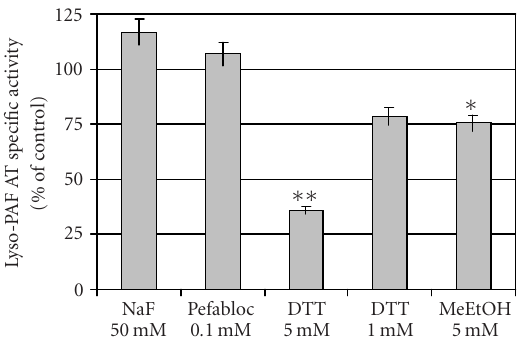
Figure 5. E ff ect of chemicals on lyso-PAF AT activity: Total membrane fractions of HMC 0 . 23mg/mL were incubated in the presence of various chemicals. Results represent the average two independent determinations using di ff erent enzyme prepa- rations performing duplicate samples and are expressed as per- cent related to non-added control (100%). (DTT; Dithiothreitol, MeETOH; mercaptoethanol, NaF; sodium fluoride) ∗ P < . 05, ∗∗ P < . 005 versus control. tissue were used. All attempts to solubilize total mem- brane fractions by sonication, in the absence of deter- gents, were unsuccessful, therefore total membranes were incubated with various solubilizing agents. Lyso-PAF AT activity and the protein concentration were measured